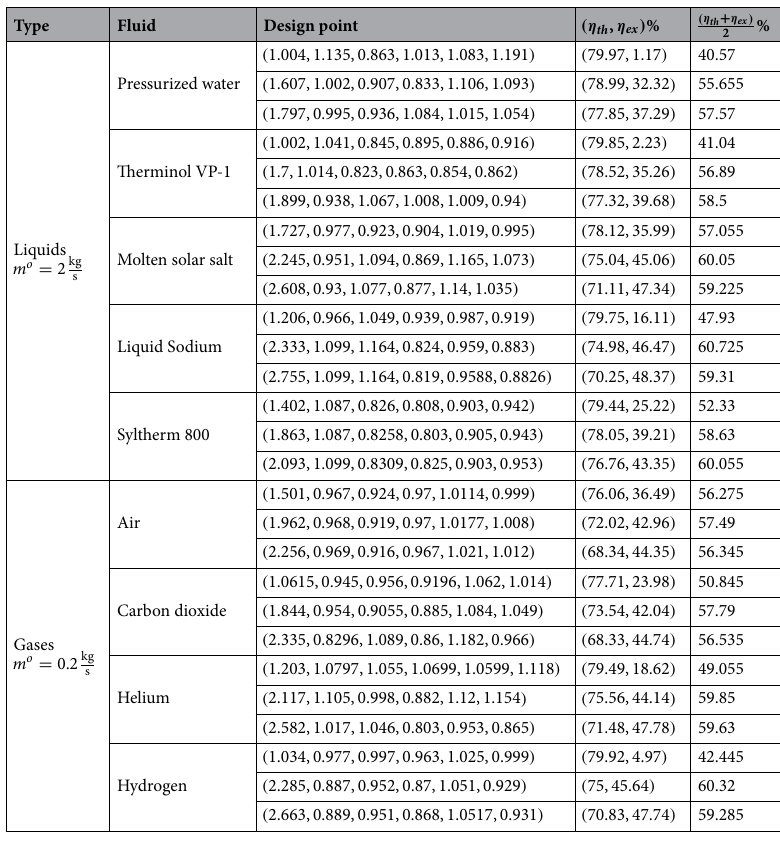
Table 7. PTC optimum